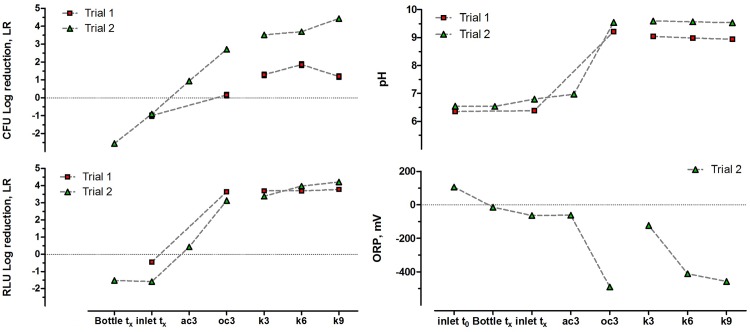
Changes in bioluminescence intensity, bacterial viability and physical-chemical parameters of anolyte.Log reduction (LR) was calculated using Inlet t0
as the reference point. LR datasets are represented by an average of 3 replicates ±SD. Closed circuit MFCs were marked by gray circles. The star * symbol indicates the first trial, while labels without symbol indicate the second trial. The data between oc3 and k3 are shown disconnected, since the two cascades were independent (see Fig 1), i.e. the effluent from oc3 did not flow into k3. ORP data are shown for Trial 2 only, due to technical problems of measurement during Trial 1.